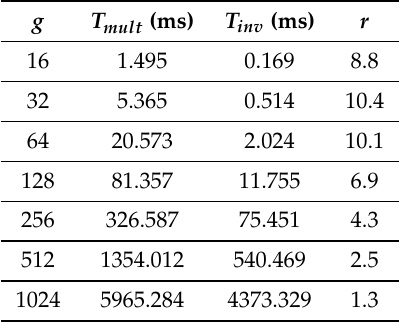
Table 2. Multiplication and inversion run-times for different generation sizes with one thread. g T mult